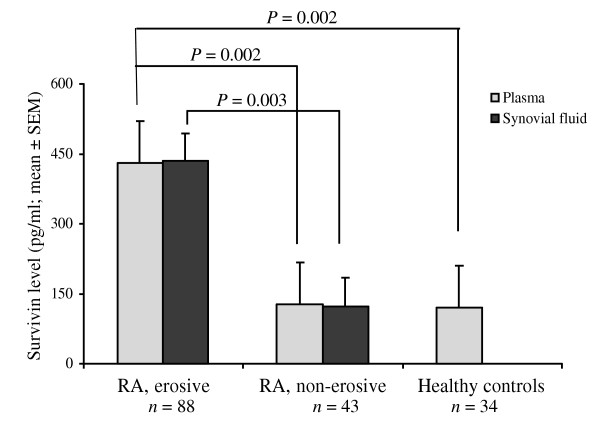
Survivin levels in plasma and synovial fluid of patients with rheumatoid arthritis (RA) are significantly increased in the case of erosive joint disease. SEM, standard error of the mean.